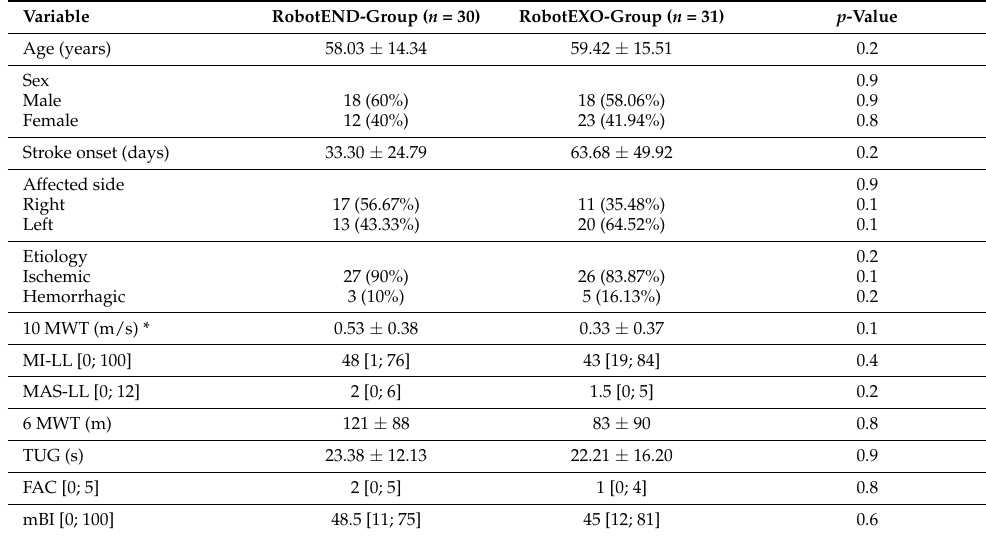
Table 2. Demographic and clinical characteristics of the End-effector Group (RobotEND-group) and Exoskeleton Group (RobotEXO-group) at baseline